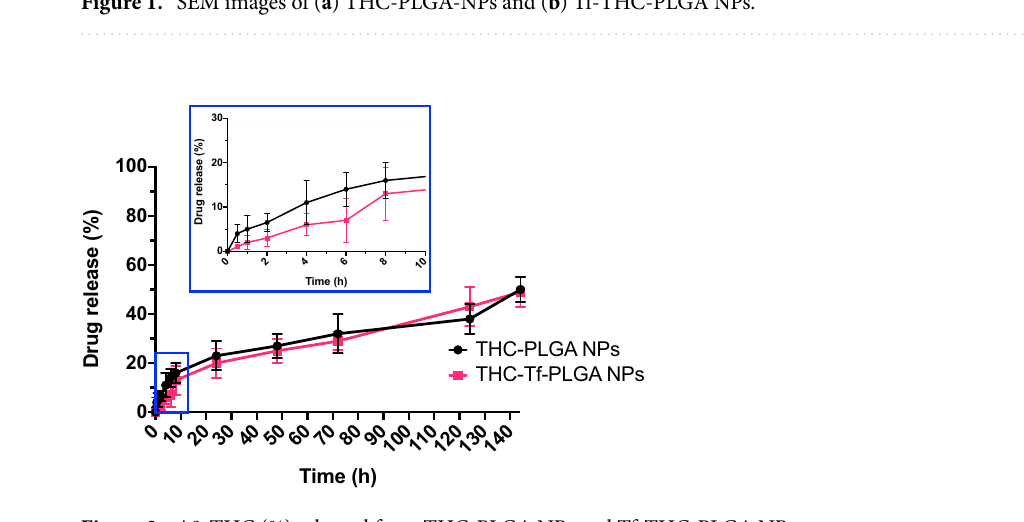
Figure 2. Δ9-THC (%) released from THC-PLGA NPs and Tf-THC-PLGA